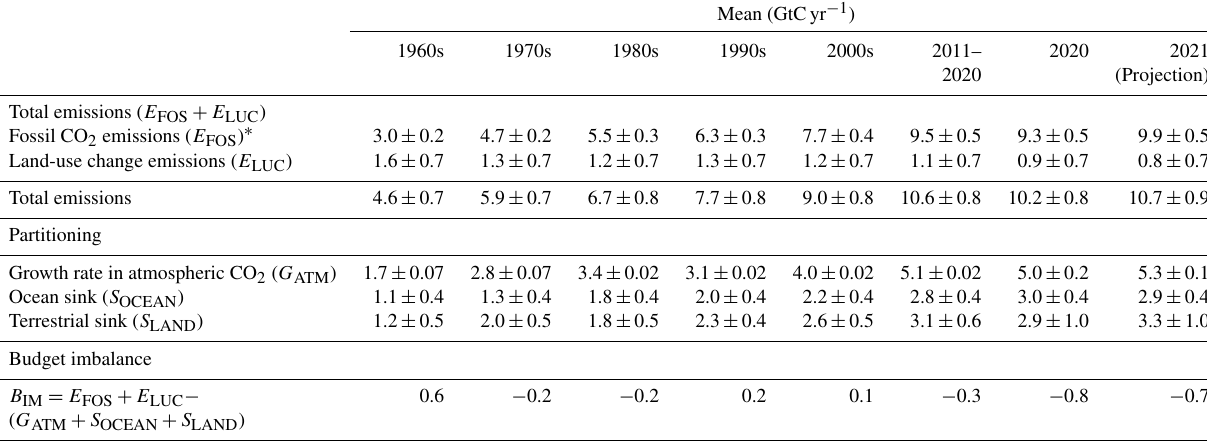
Table 6. Decadal mean in the five components of the anthropogenic CO 2 budget for different periods, and last year available. All values are in GtCyr − 1 , and uncertainties are reported as ± 1 σ . Fossil CO 2 emissions include cement carbonation. The table also shows the budget imbalance ( B IM ), which provides a measure of the discrepancies among the nearly independent estimates and has an uncertainty exceeding ± 1GtCyr − 1 . A positive imbalance means the emissions are overestimated and/or the sinks are too small. All values are rounded to the nearest 0.1GtC and therefore columns do not necessarily add to